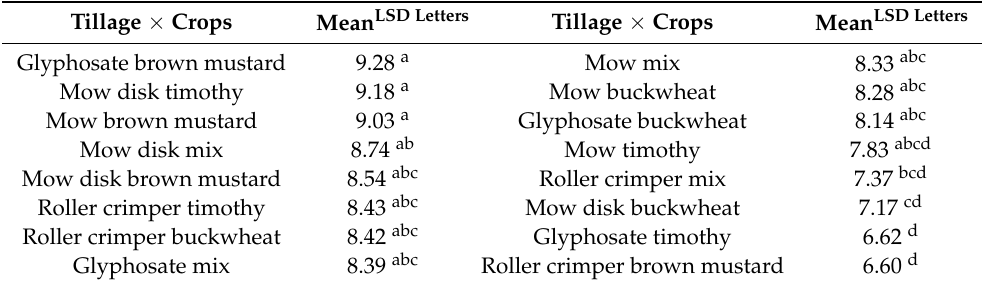
Table 7. Multiple mean comparisons of P/Al (%) produced by the different cover crops and their incorporation methods using Fisher’s least significant difference (LSD)